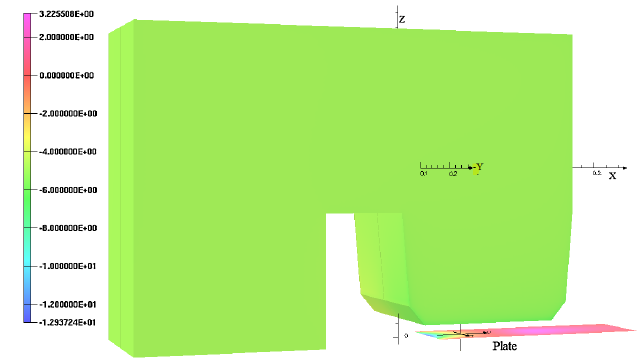
FIG. 10. One half of the 3D model used for simulation study is shown here. Different colors represent the eddy current ( A = mm 2 ) in the plate for 50 Hz frequency. Note that there is no eddy current in the magnet